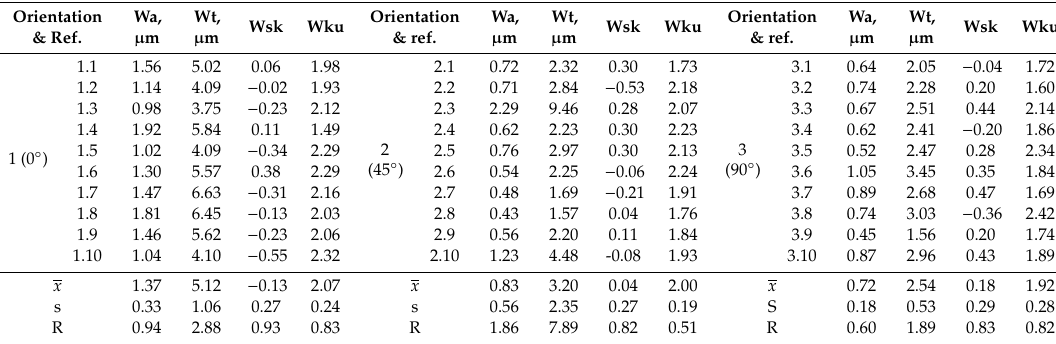
Table 4. Waviness parameters versus orientations for the lateral